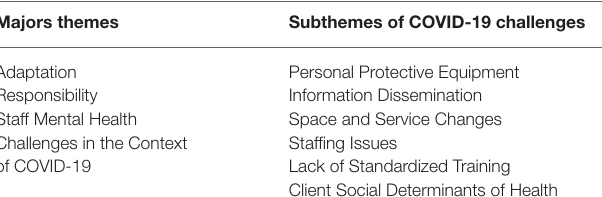
TABLE 3 | Listening session themes and COVID-19